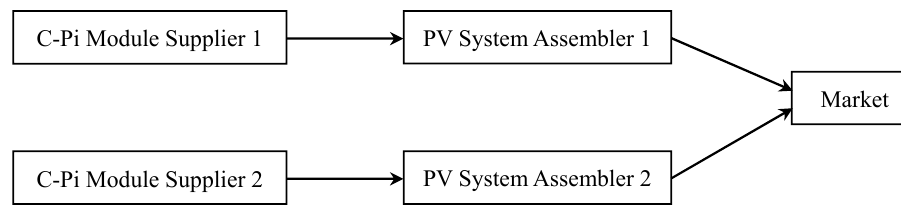
Figure 1. Dual competing PV supply chains.